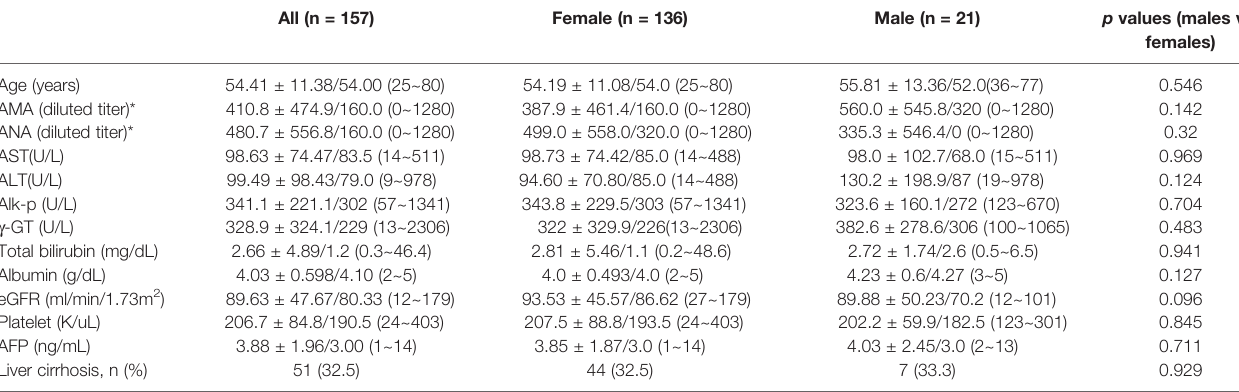
TABLE 1 | Baseline characteristics of the patients with primary biliary cholangitis [mean+/-standard deviation/median (range)]. All (n =